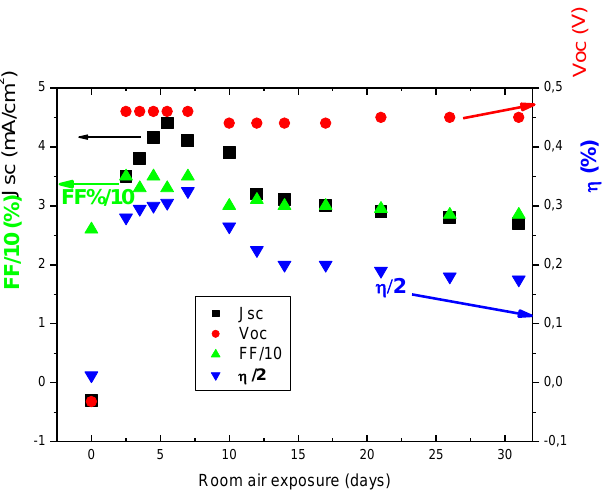
Figure 3. Variation with time of the typical performance of an OPVC with Alq (3 nm)/MoO (6 nm) as the CBL: (■) Jsc, (●) Voc, (▲) FF and (▼) η/2. 3